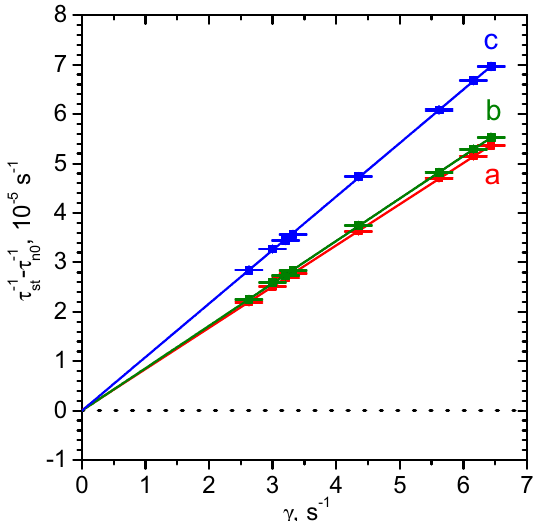
Figure 5. Extrapolation of the neutron lifetime using the simulated values for τ − 1 , for three values of uncoated area st fractions: (a) 0%; (b) 0.1%; (c) 1%.